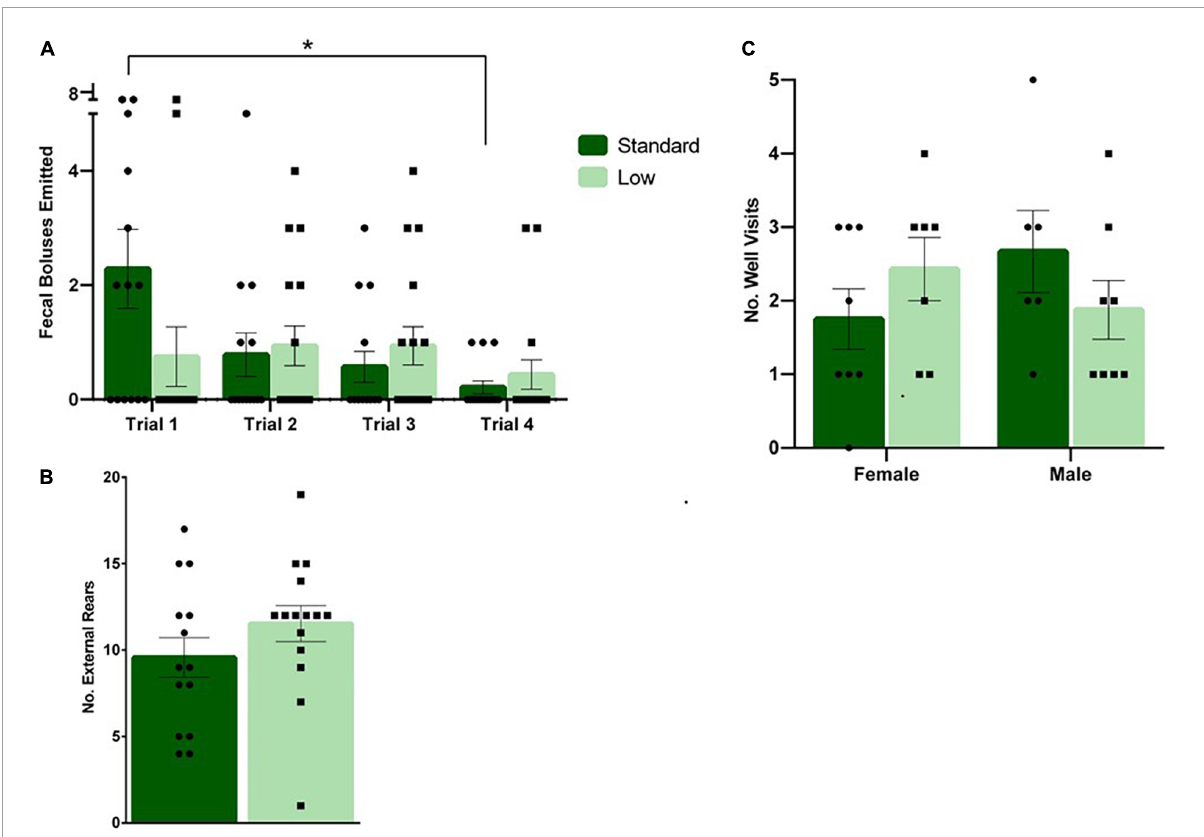
FIGURE7 Dry land maze. (A) Following a repeated-measures mixed ANOVA analysis on data collected during the four training trials, it was found that standard rats emitted a higher number of fecal boluses during trial 1 compared to trial 4 (* p = 0.031). No differences were detected across time for low resource rats ( n = 16 for SR group, n = 14 for LR group). (B) During the probe trial, a trend was observed showing low resource rats exhibited external rears at a greater frequency than standard resource rats ( p = 0.068; n = 8 for SR Females, SR Males, and LR females; n = 6 for LR males). (C) Also during the probe trial, low resource females were found to visit more wells compared to standard females, and standard males were found to visit more wells than low resource males ( p = 0.069). Individual data points overlay bars showing means ± SEM; n = 16 for SR group, n = 14 for LR